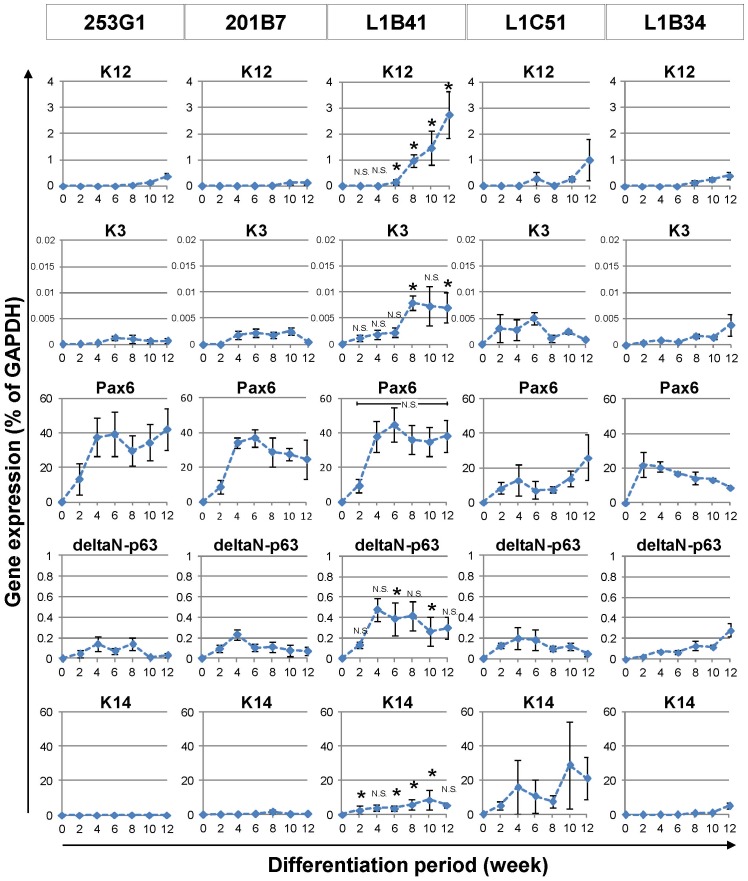
Gene expression analysis for corneal epithelium-related markers in iPS cells at various time points during differentiation by the SDIA method.While L1B41 began expressing significant levels of K12 after 6 weeks, other iPS cells began exhibiting K12 expression at approximately 10 weeks or later, and K12 expression in L1B41 was significantly higher than 253G1 at 6–12 weeks. Significant K3 expression levels were detected in L1B41 cells after 8 weeks in SDIA culture. Pax6 and delta-N p63 began to be expressed at 2 weeks and kept a similar expression pattern for several weeks in all iPS cells. K14 was highly expressed in both L1B41 and L1C51. The graph shows the mean ± S.E. of 3–7 independent samples. *p<0.05 (L1B41 vs. 253G1, Mann-Whitney rank-sum test), N.S. = not significant.